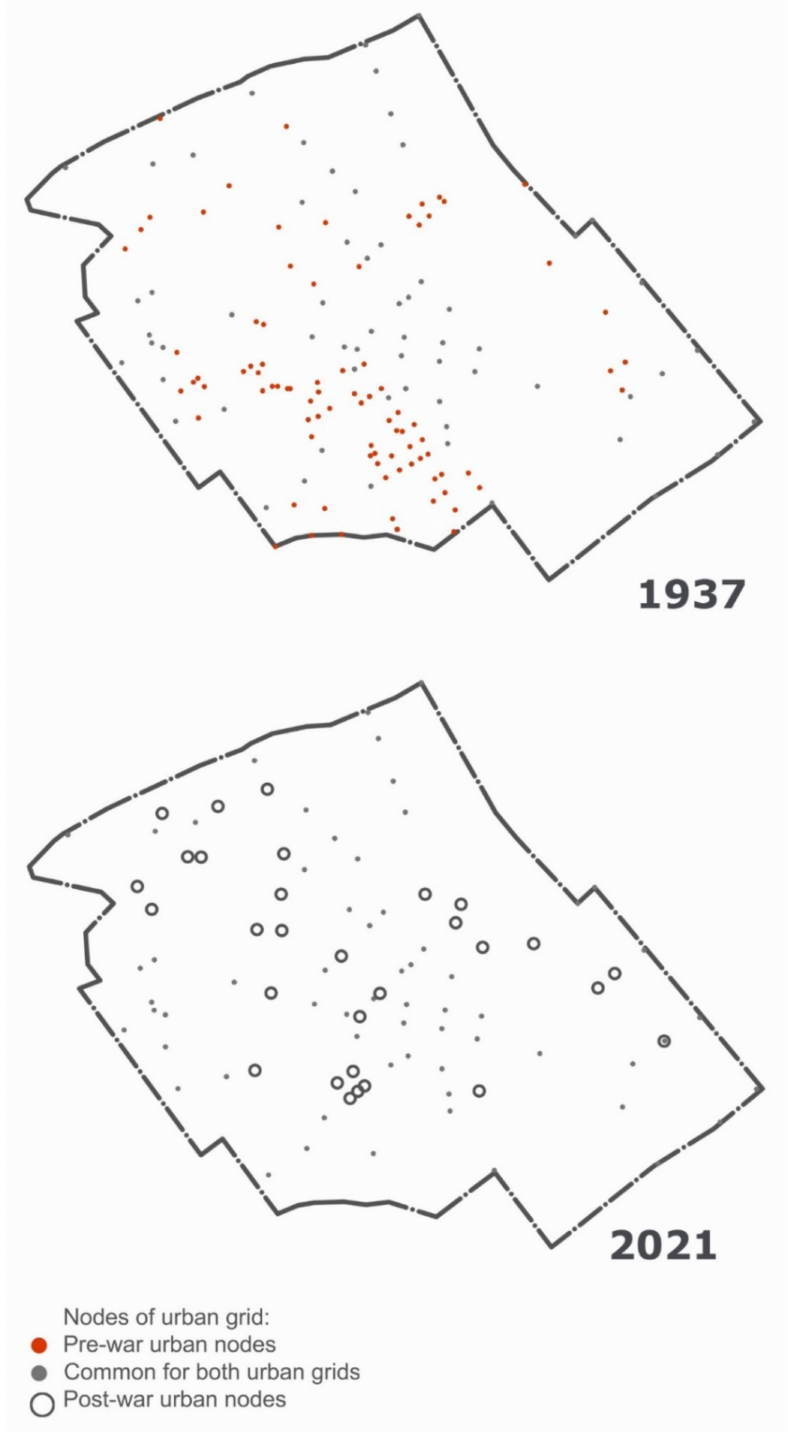
Figure 5. Nodes of urban grid on research area in 1937 and 2021; prepared by M.